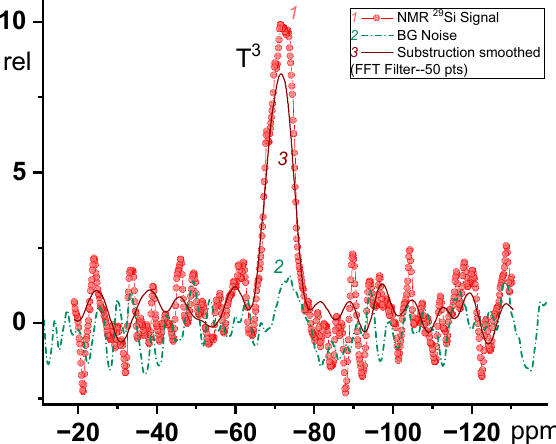
Figure 5. 29 Si NMR-spectra of UV-rGO modified with TMSPM (1), background noise (2) and (3) subtracted by (2) on (1), smoothed using 50 points by FFT filter in the OriginPro 2021.